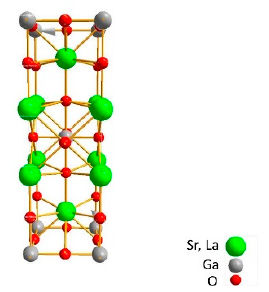
Figure 2. Schematic crystal structure of SrLaGaO4.